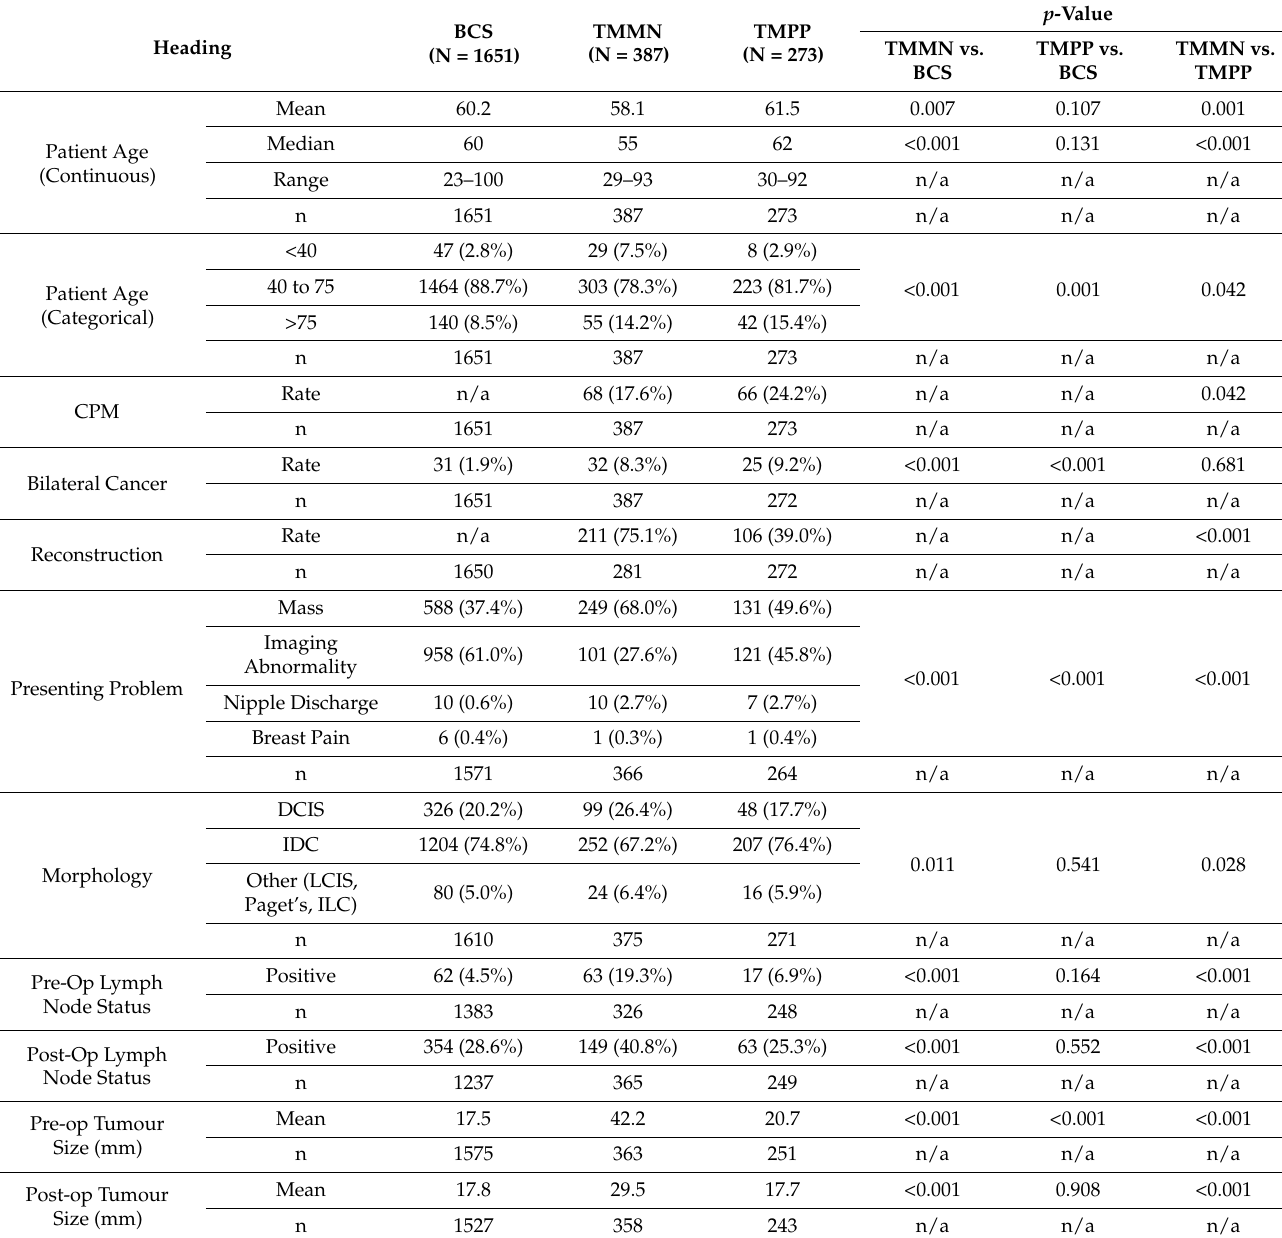
Table 1. Patient and tumour